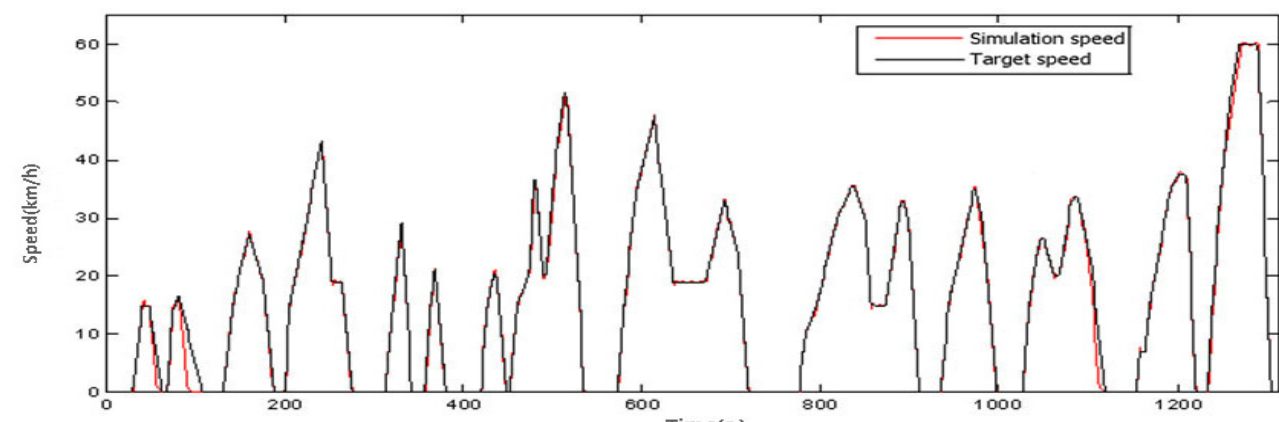
Figure 14. Optimization of vehicle velocity in gears 5 to 4.